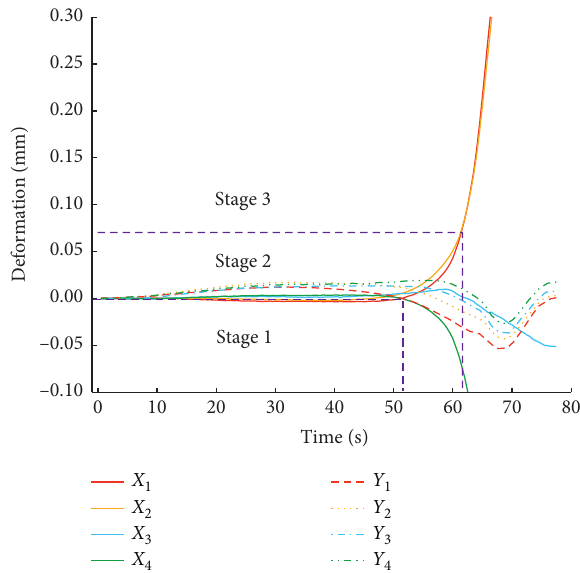
Figure 5: Displacement evolution of measuring point in